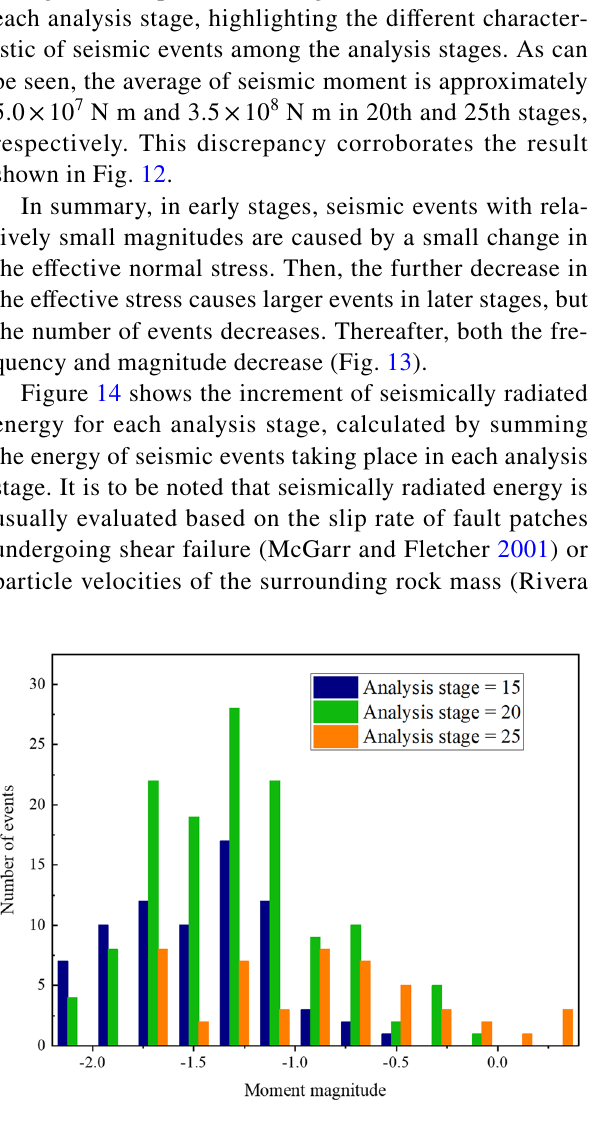
Fig. 14 Energy released during each analysis